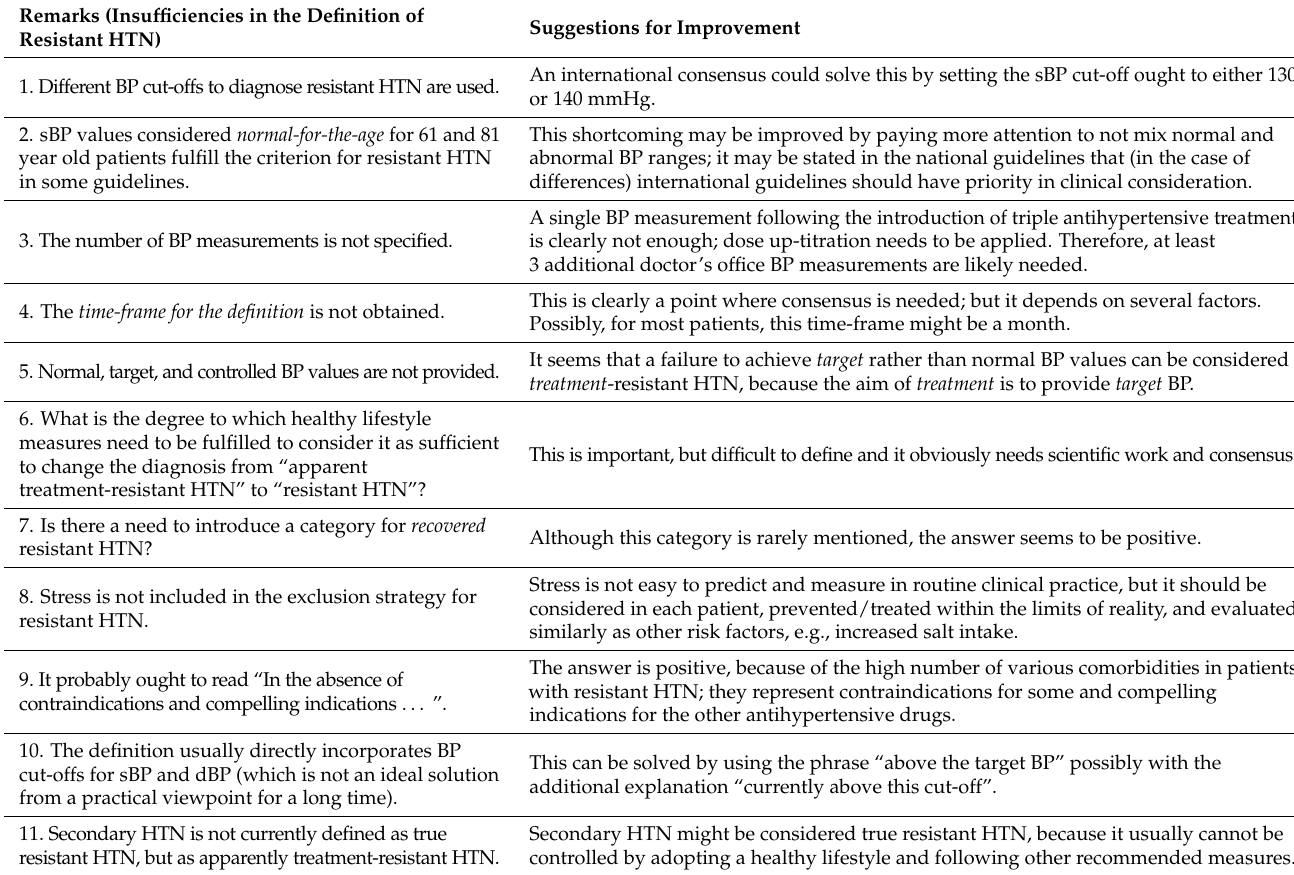
Table 2. Suggestions for the improvement of current definition, as a starting point, to be considered by experts in the field in hypertension